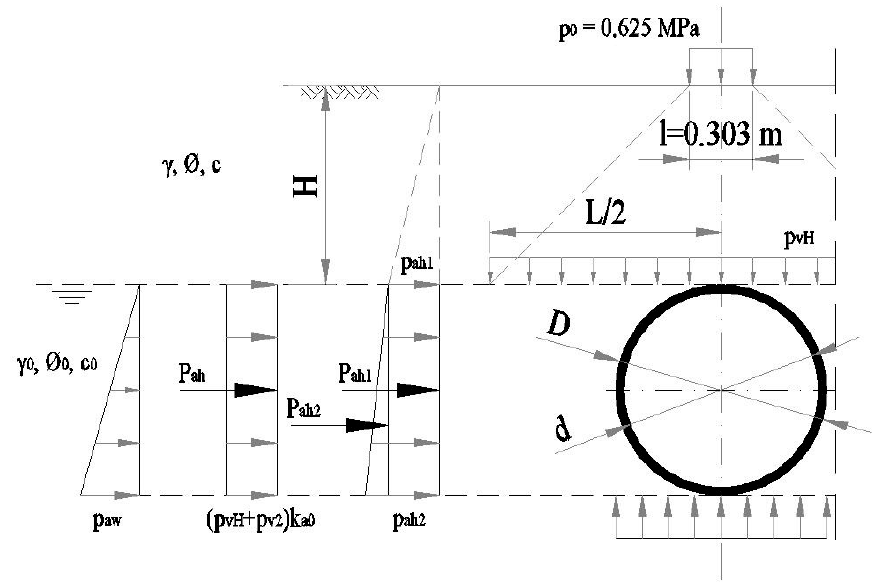
Figure 3. Pipeline loadings calculation model.